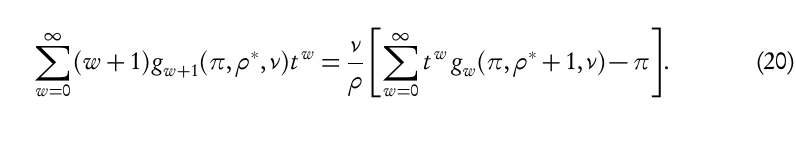
Combining relation (18) and (19) together lead the